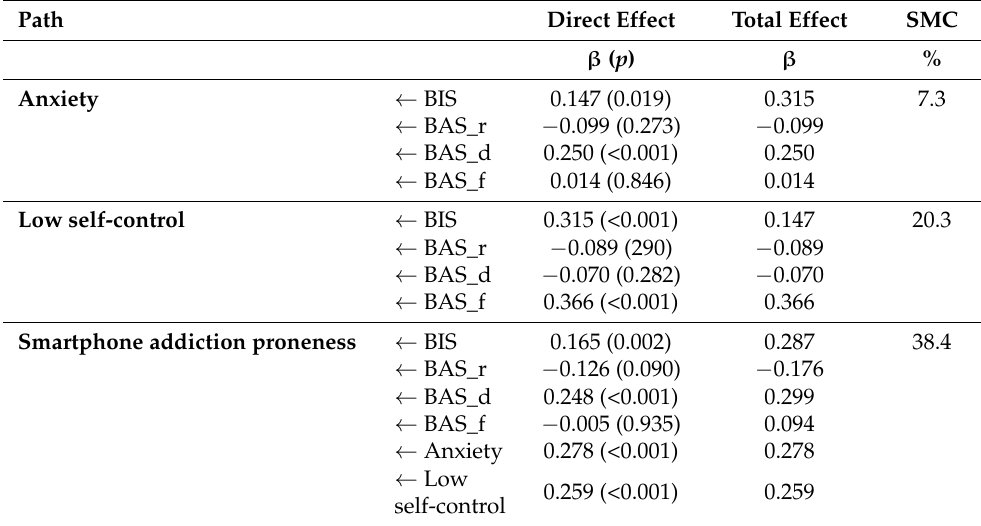
Table 4. Standardized direct and total effects of study variables ( n =